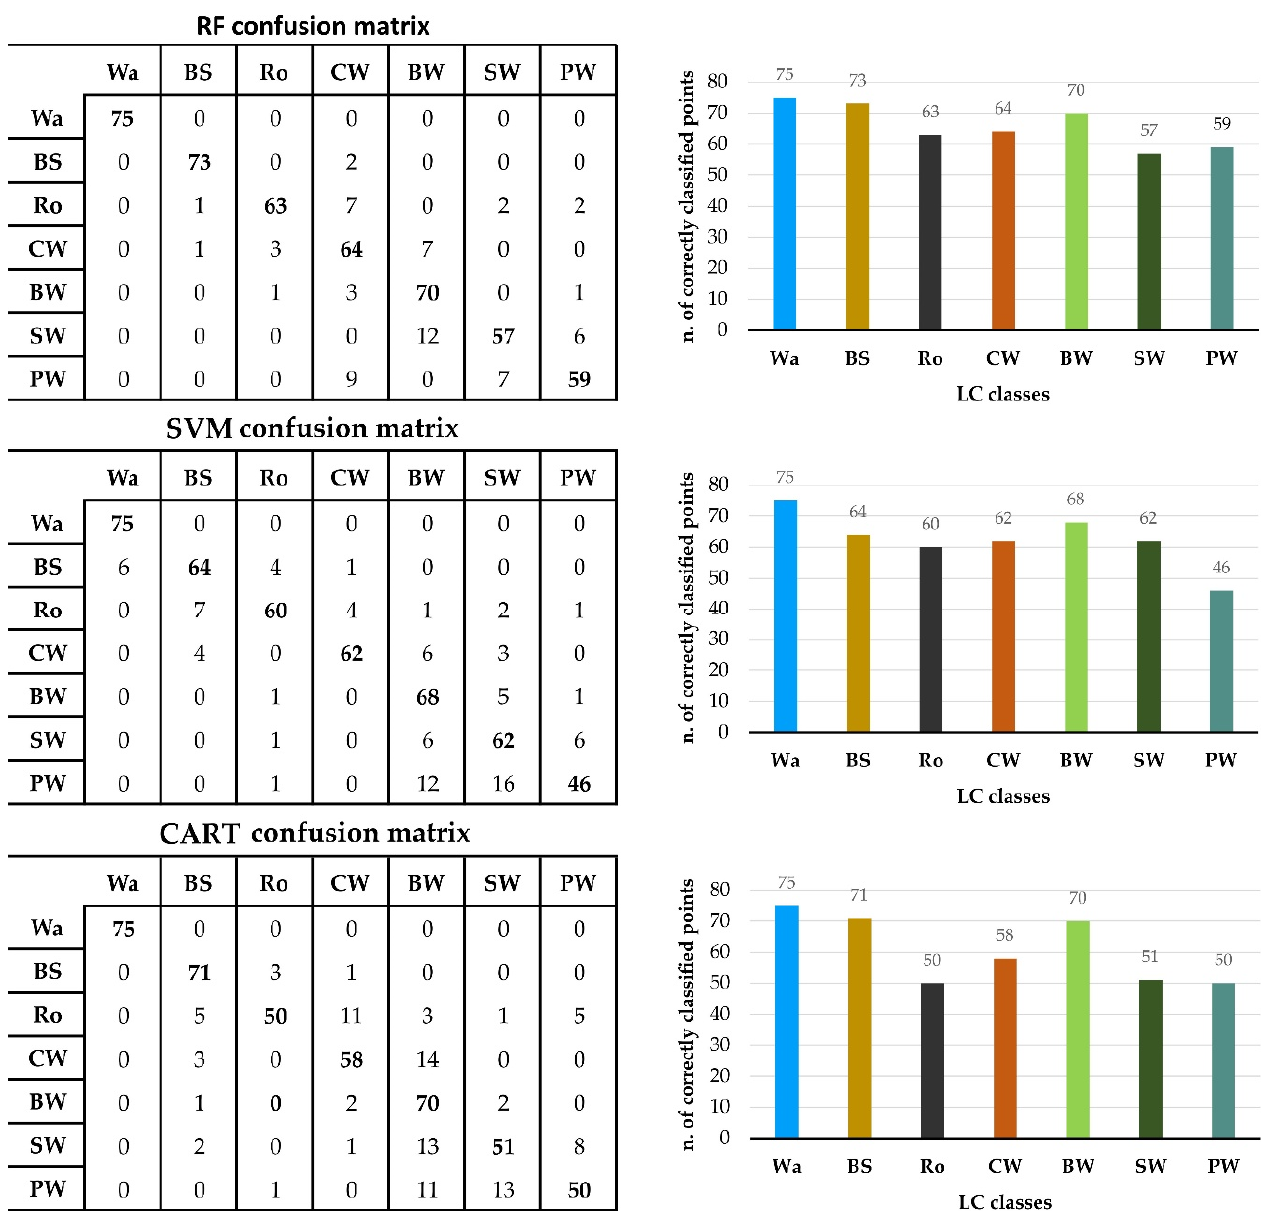
Figure 4. Confusion matrices and charts for each adopted classifier (RF: random forest; SVM: support vector machine; CART: classification and regression tree) and for each adopted land ‐ cover (LC) class (Wa: water; BS: bare soil; Ro: roads; CW: chestnut woodland; BW: beech woodland; SW: silver fir woodland; PW: pine woodland).